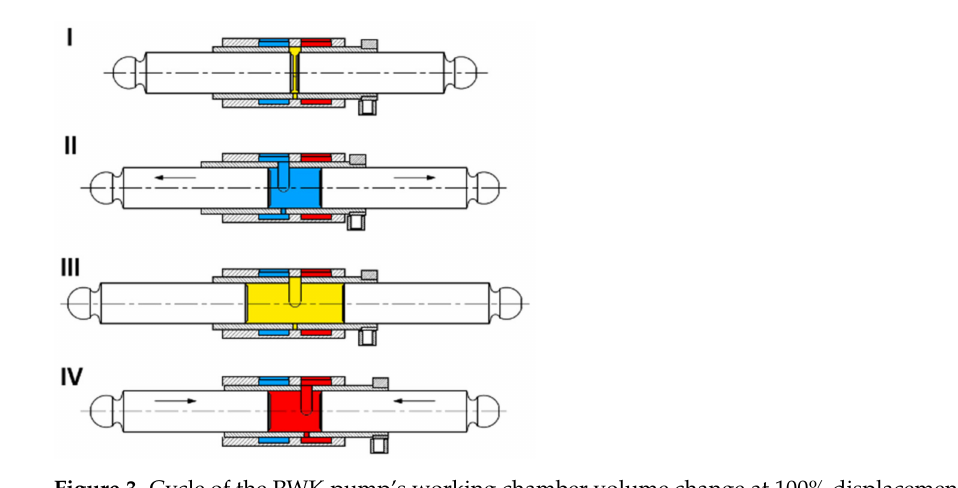
Figure 3. Cycle of the PWK pump’s working chamber volume change at 100% displacement [12].